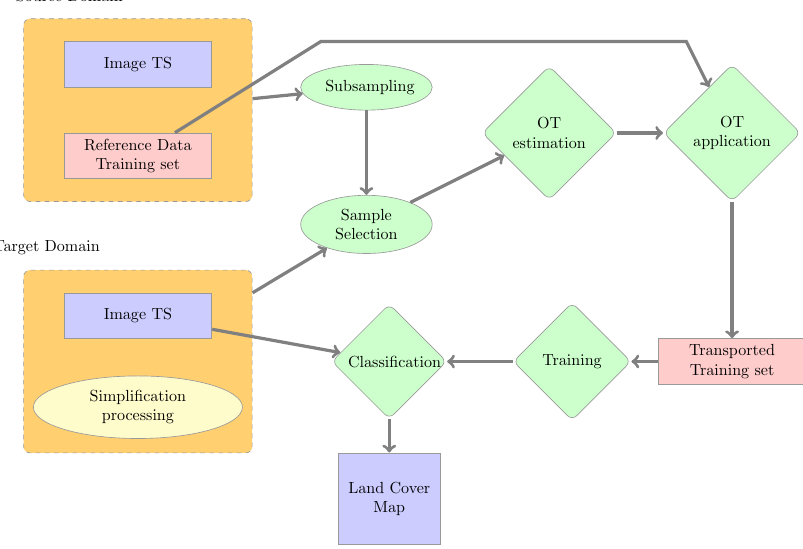
Figure 3. Land-cover mapping using OT for adapting the data. The algorithms used are represented by diamonds and the sampling strategies indicated by ellipses. The yellow ellipse represents the different simplification procedures proposed in this